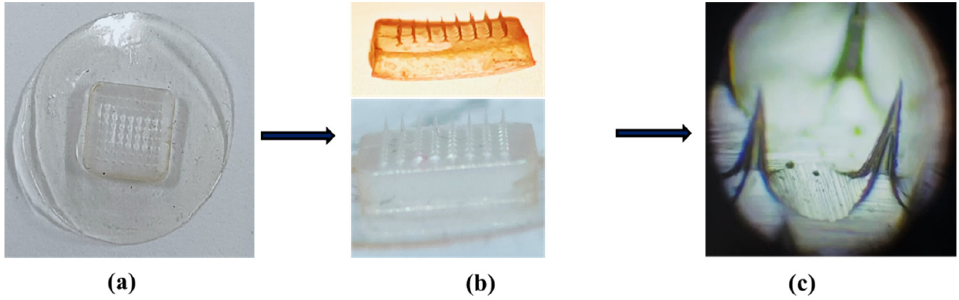
Figure 1. Microneedle patch F26, ( a ) macroscopic aerial view, ( b ) macroscopic side view and ( c ) microscopic view showing clear pointed needles.